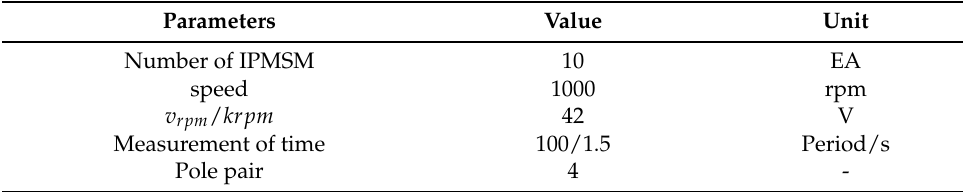
Table 1. Experiment